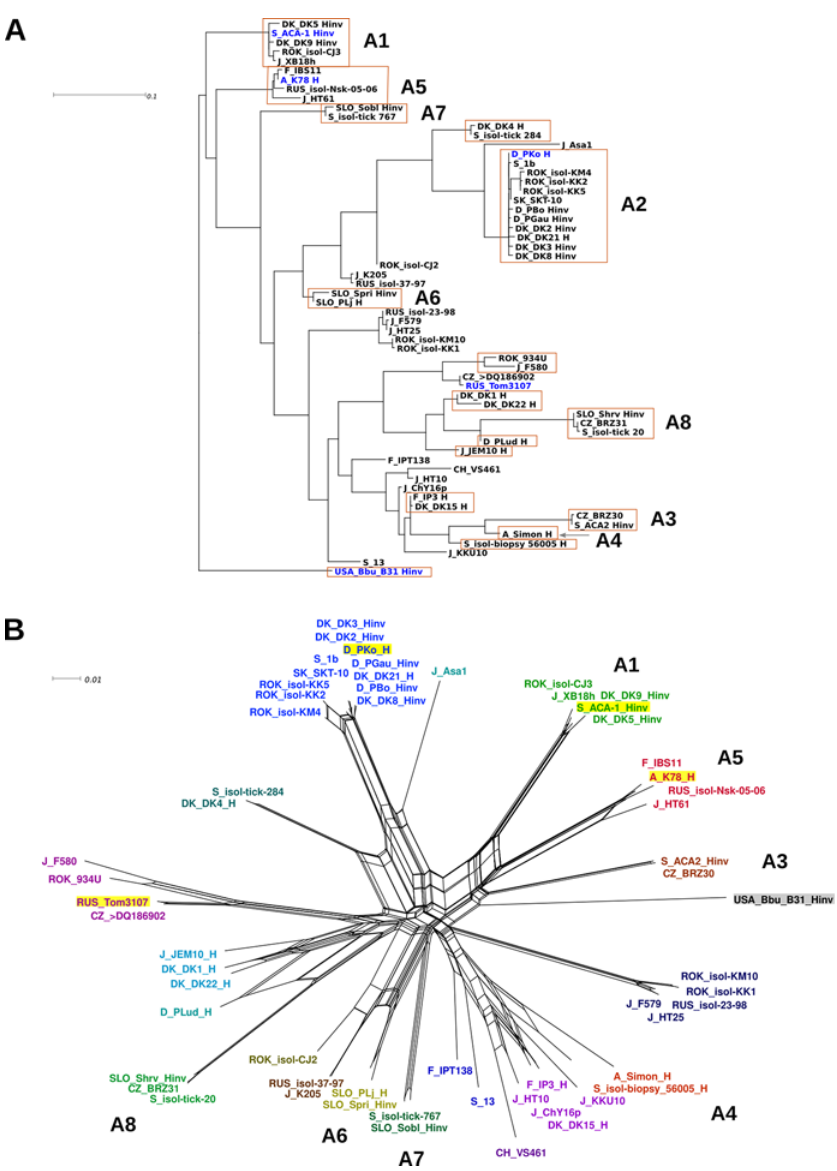
Fig 2. Alignment of B . afzelii K78 ospC sequence against the sequences of B . afzelii strains from public databases. A non-redundant set of partial ospC sequences according to BAFK78_B0019 bp 97 – 583, comprising 59 B . afzelii strains and the sequence of B . burgdorferi B31 as external root reference were included in the analyses. A: Maximum likelihood tree representation, re-rooted with B . burgdorferi B31 as outgroup. Clusters containing strains attributed to human infectivity are boxed, of which the previously identified groups were labelled A1 – A8. The strains compared in this study are highlighted in blue. B: A recombination network representation is shown for the sequences in an unrooted distance phylogram. The pairwise homoplasy index test for the B . afzelii sequences (p = 7.8x10 -15 ) indicates significance for the presence of recombination events. The strains compared in this study are highlighted by a yellow